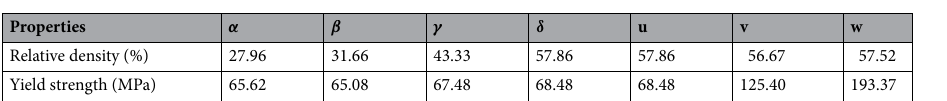
Table 4. Relative densities and the corresponding yield strength of MGSs in Group 3 and Group 4.